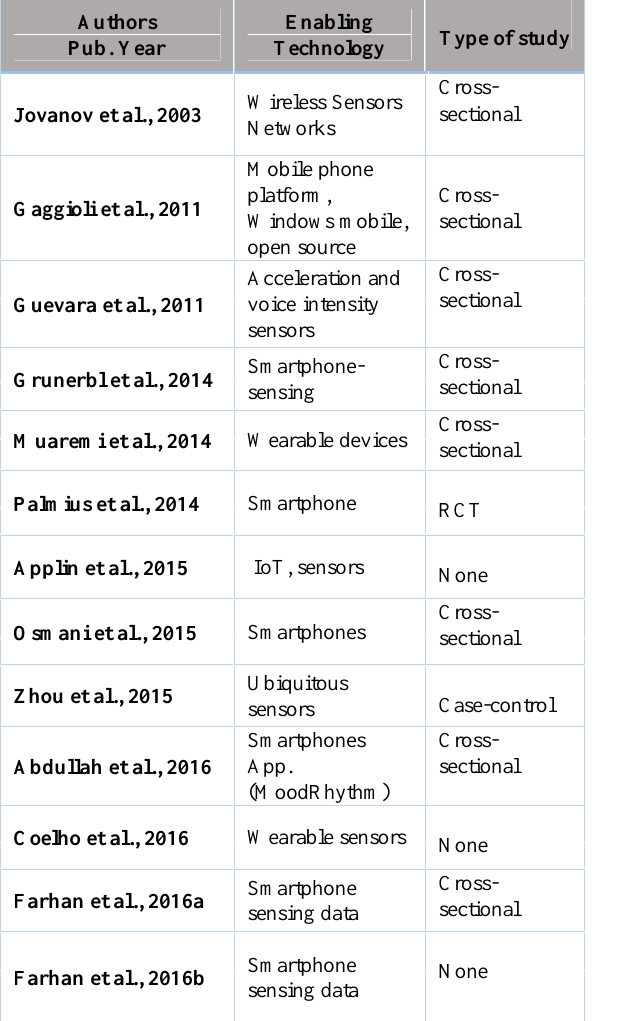
Table 1. Summary of the literature